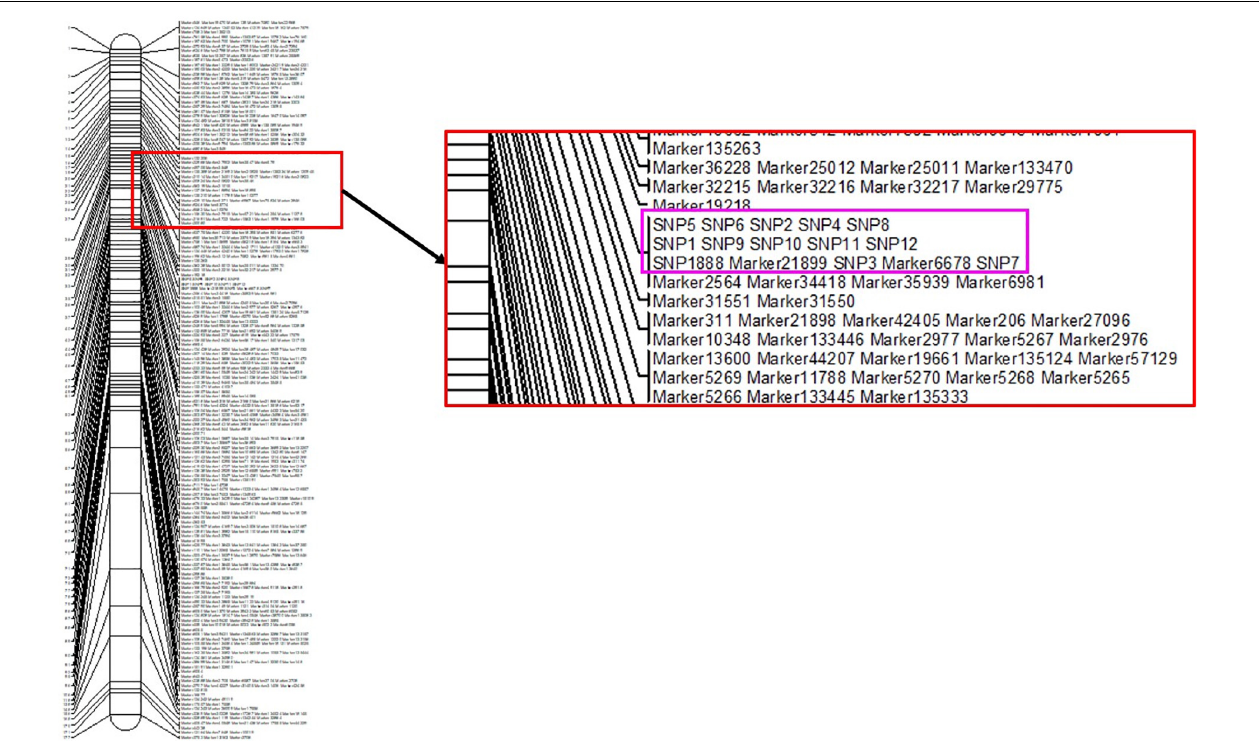
FIGURE 3 | Mapping results of Sp-Pol gene (SNP1888) in the genetic map of Scylla paramamosain .